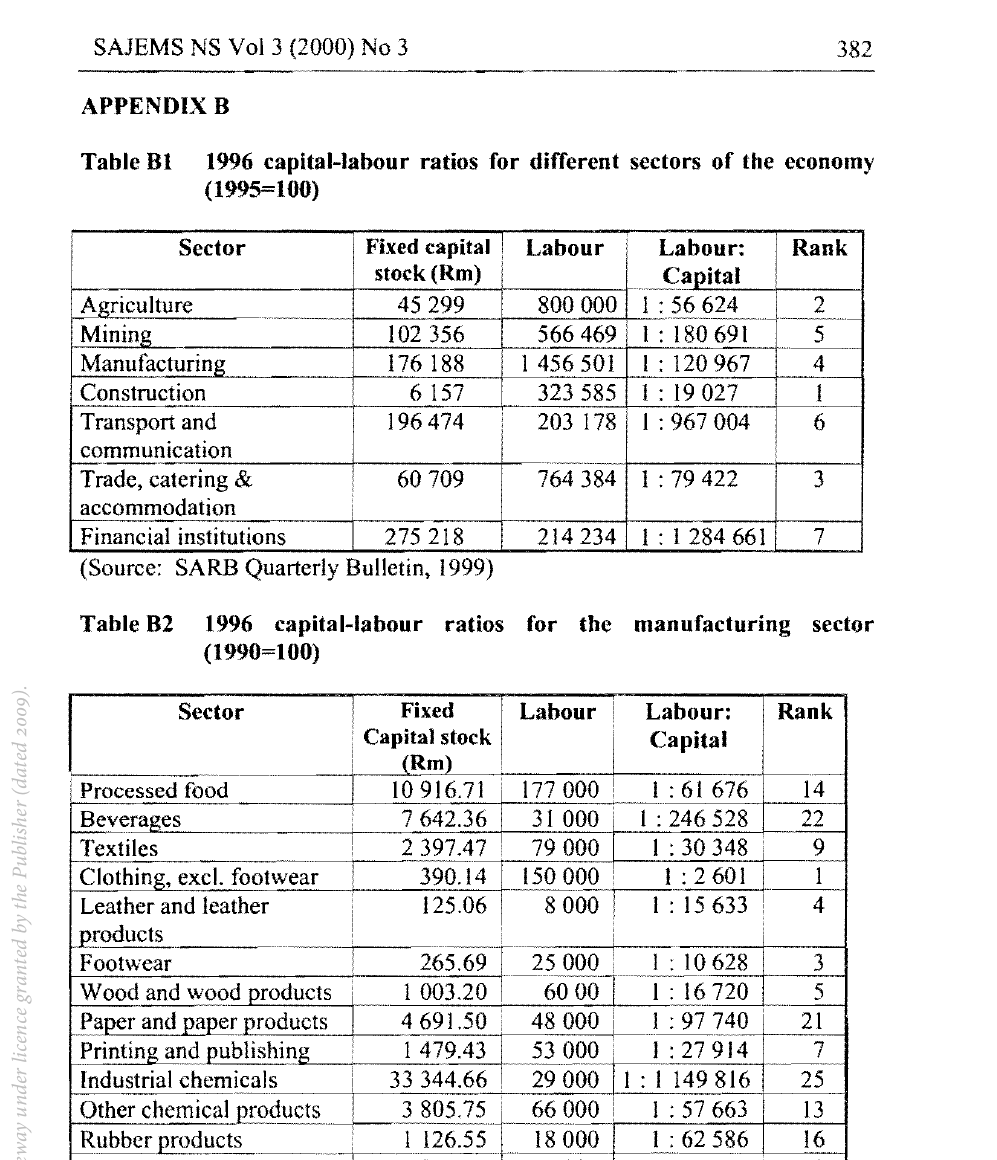
1996 capital-labour ratios for tbe manufacturing sector (1990=100)